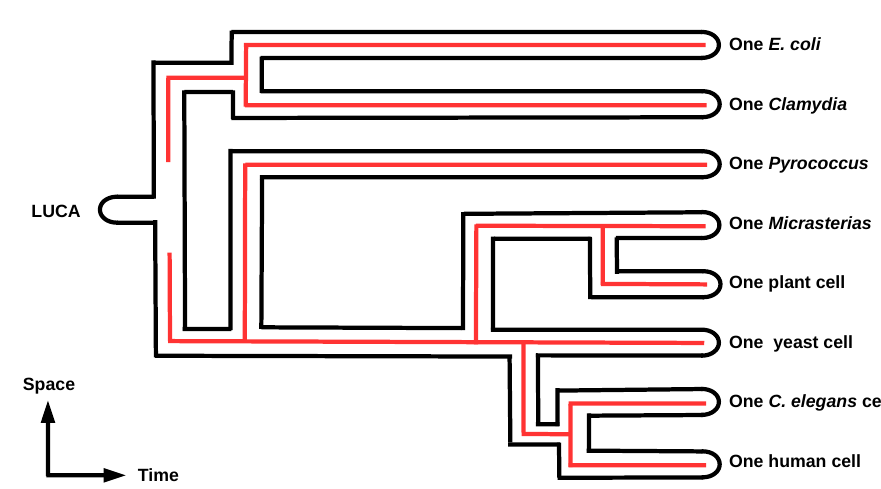
Figure 5. A phylogenetic tree showing the cell membrane (solid black lines) and cytoplasm (enclosed space) as well as the genome (red lines) from the last universal common ancestor (LUCA) to the present. Whether LUCA has a well-defined genome is left open. All compartments of the cell are continuous from LUCA to the present across all of phylogeny; hence, all cellular compartments can serve as